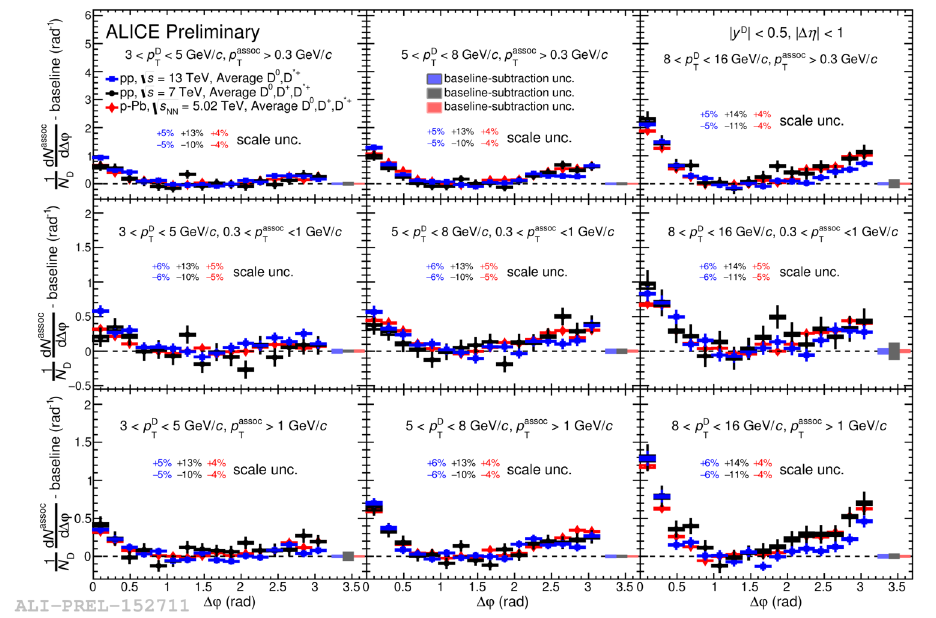
Figure 1. Comparison of azimuthal correlation distributions of D mesons with charged particles in pp and p–Pb collisions after baseline subtraction, for di ff erent kinematic